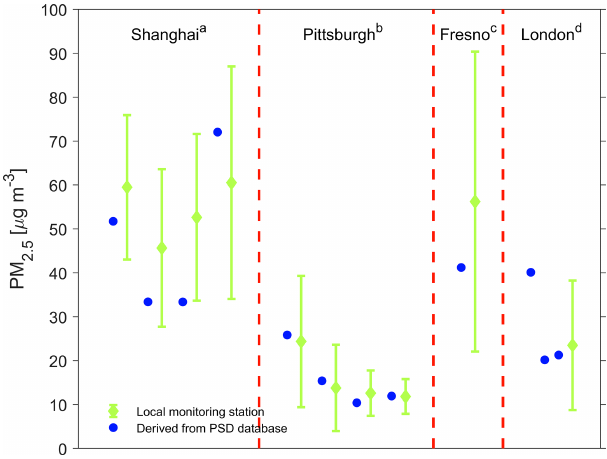
Figure 3. Comparison of size-integrated PM 2 . 5 mass concentra- tions derived from the PSDs collected in this study (blue circular markers) with those measured by local monitoring stations in the same city over the same sampling periods (green diamond mark- ers and error bars). The green diamond markers represent the mean values of the PM 2 . 5 mass concentrations from local sampling sta- tions over the sampling period of the corresponding PSD, and the error bars represent the standard deviations of the mean PM 2 . 5 mass concentrations. a PSDs from Ding et al. (2017) and PM 2 . 5 from Shanghai Environment Monitoring Center at Hongkou Liangcheng station, including four different sampling periods. b PSDs from Cabada et al. (2004) and PM 2 . 5 from U.S. EPA monitoring station (42-003-0021), including four different sampling periods. c PSD from Watson et al. (2002) and PM 2 . 5 from U.S. EPA monitoring sta- tion (06-019-0008). d PSDs from Harrison et al. (2012) and PM 2 . 5 from UK Automatic Urban and Rural Monitoring Network at Lon- don Marylebone Road. Three PSDs were measured at three different sampling sites over the same